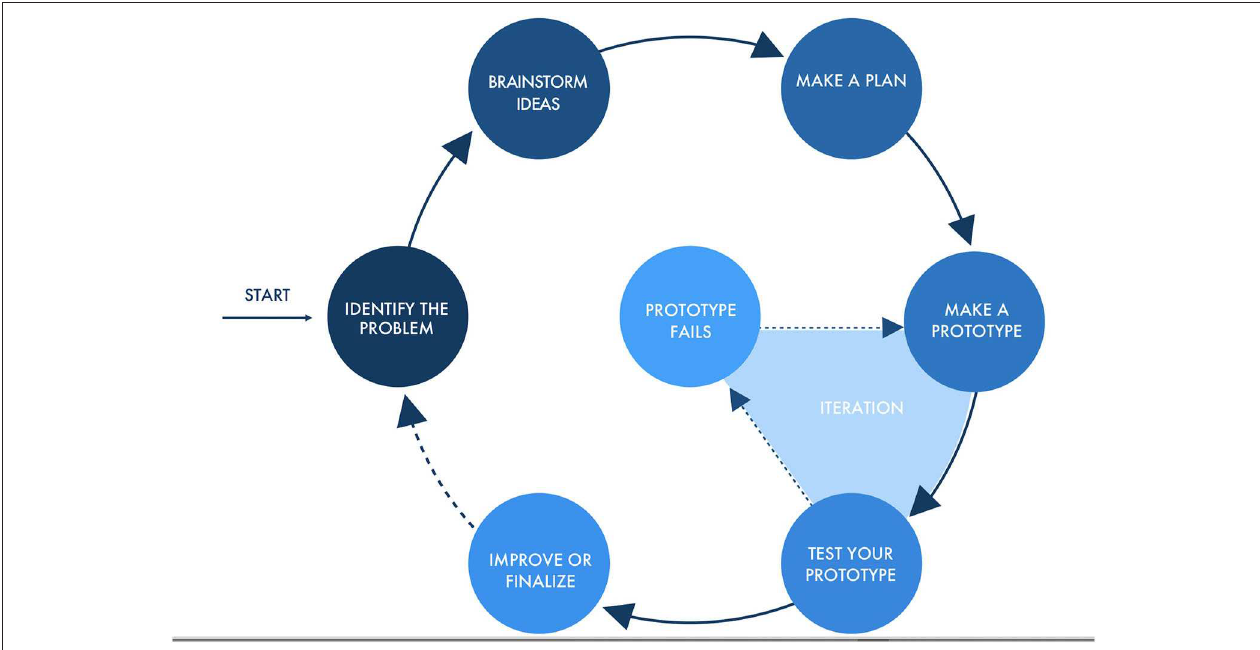
FIGURE 1 | Engineering design process